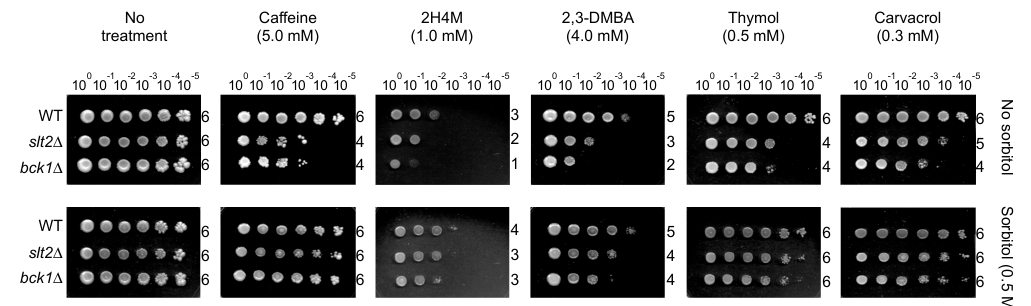
Figure 3. Yeast dilution bioassay showing sensitivity of S. cerevisiae slt2 Δ and bck1 Δ mutants to caffeine (5 mM; control) and test compounds (2H4M, 2,3-DMBA, thymol, carvacrol) was remediated by sorbitol. Results indicate the test compounds negatively affected cell wall integrity system of fungi.